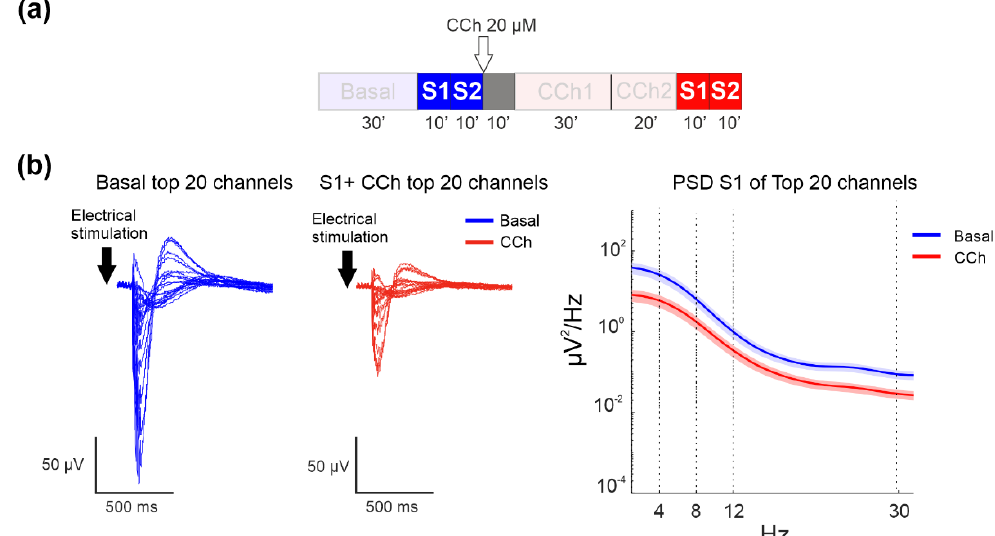
Figure 5. LFP analysis of the evoked response. ( a ) Experimental protocol adopted for the experiments. The electrical stimulation phases analyzed here are highlighted. Cortical cultures were stimulated for 10 min at two different sites under basal conditions and after CCh treatment. ( b ) Left panel: Mean evoked responses of the top 20 channels in one representative experiment during basal conditions and after CCh administration. Right panel: Comparison of the mean PSD of the two different experimental phases: the bold lines and shaded regions correspond to the mean ± SEM.